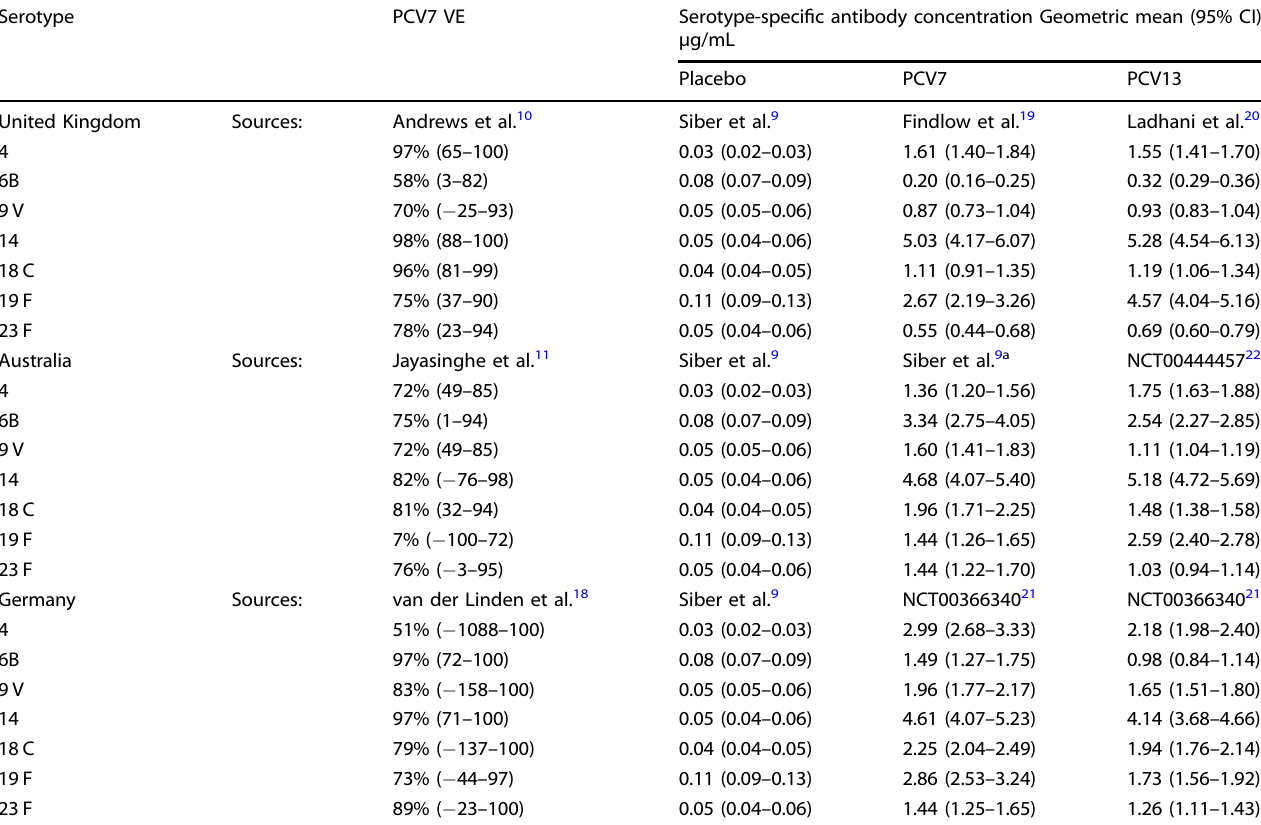
Table 4. Summary-level input data.